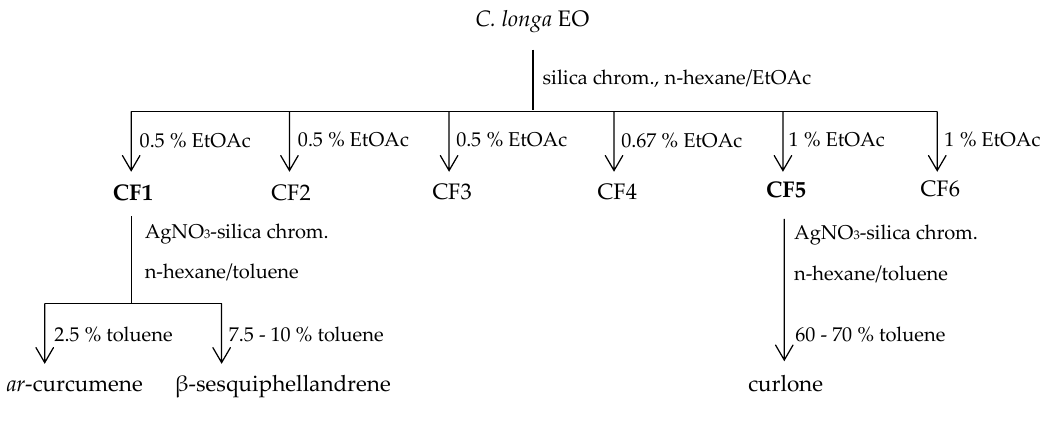
Figure 3. Isolation of β -sesquiphellandrene, ar -curcumene, and curlone from C. longa EO.